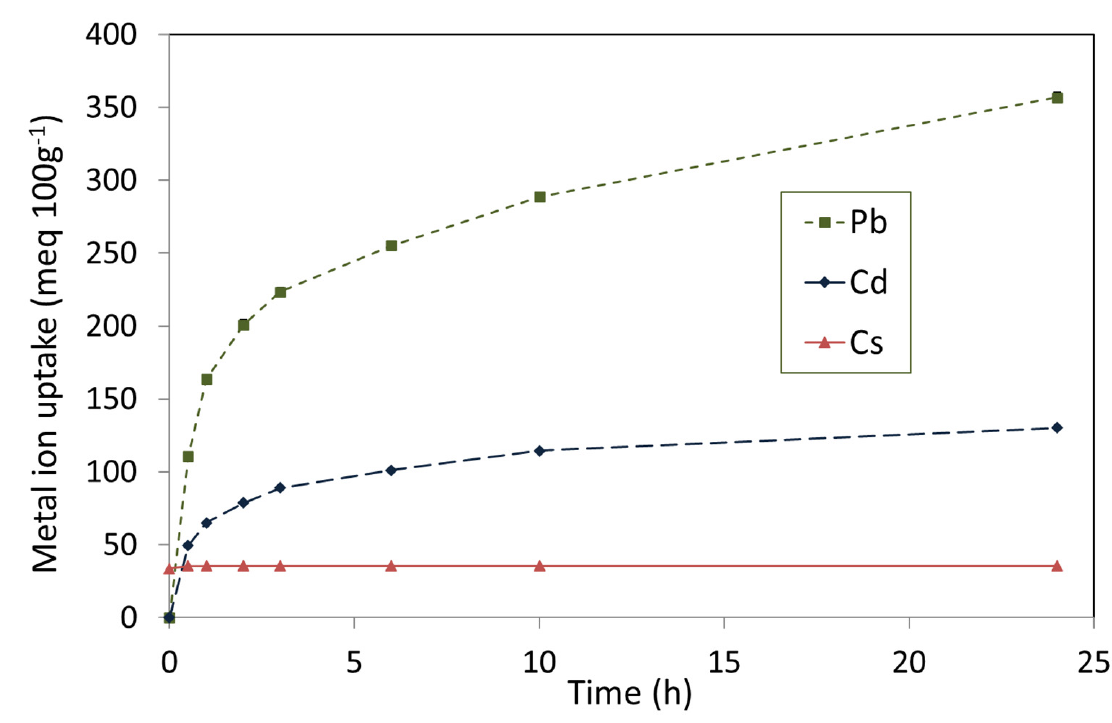
9 Figure 5. Secondary electron images of the 7-day hydrothermal product (TOB-7). 3.2. Cation Exchange Capacity and Cs + Selectivity The Cs + for K + cation exchange capacity of TOB-7 was found to be 59 ± 4 meq 100 g − 1 (i.e., 0.59 mmol g − 1 , 32.5 mg g − 1 ). The 7-day hydrothermal product exhibited a preference for Cs + over Na + and Ca 2+ , respectively removing 55 and 59% of Cs + ions from binary so- lutions in which the [Cs + ]:[Na + ] and [Cs + ]:[Ca 2+ ] ratios were 1:100. The corresponding dis- tribution coefficients, K d , for the selective removal of Cs + were estimated to be 574 ± 13 and